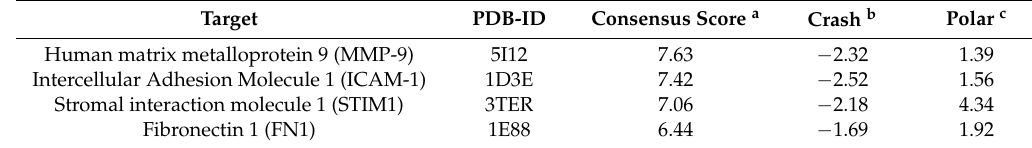
Table 1. Docking score values of candidate metastasis-related targets of wogonin.